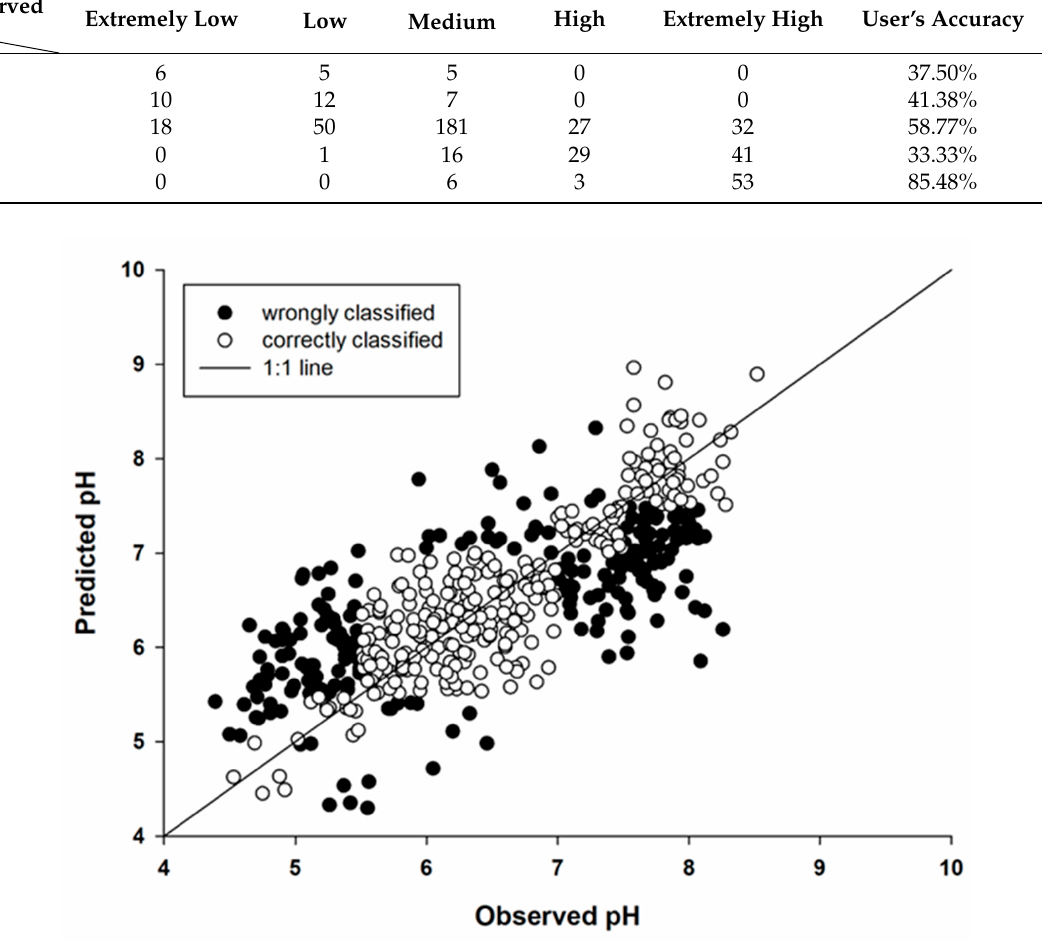
Figure 4. Scatterplot of the predicted pH values versus the observed pH values. Table 8. Allocation confusion matrix of pH.